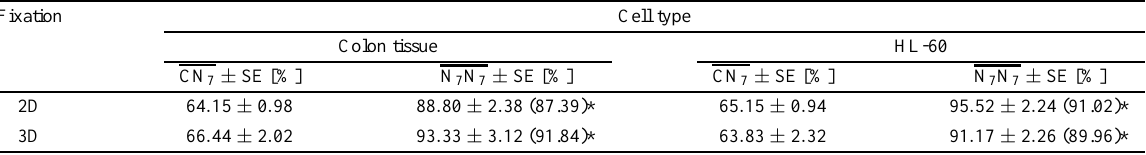
The results obtained for nuclei of HL-60 cells fixed in both 2D and 3D are also shown for comparison. The number of investigated cells was 200–300 for 3D analysis and 800–1000 for 2D analysis. CN 7 – average centre-of-nucleus to centromere 7 distance; N 7 N 7 – average value of signal to signal distribution of homologous centromeres 7 p n , where n is the number of experiments (typical number is 3). (the distances are shown in % of the nuclear radius, R ); SE = SD = (cid:3) Theoretical values calculated by Monte-Carlo simulations using experimentally determined centre to signal distributions (according to RS